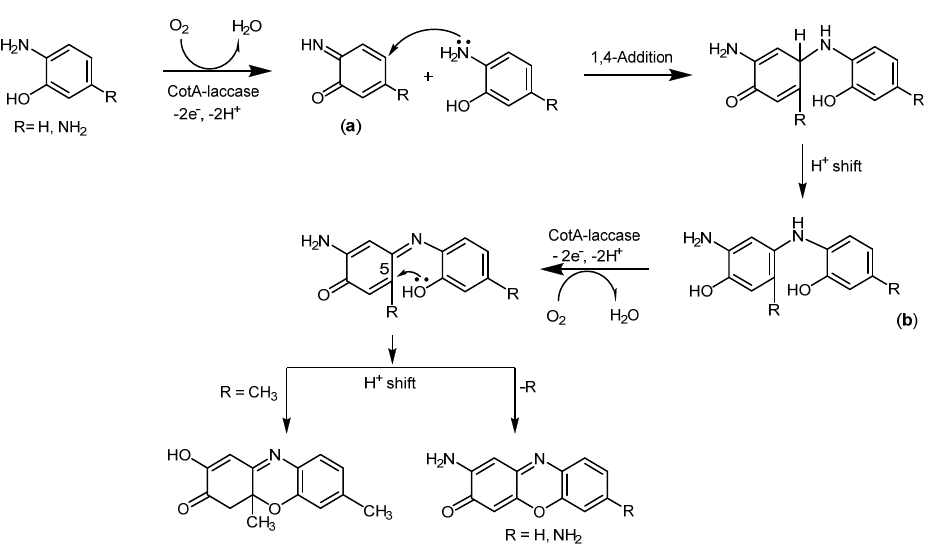
Scheme 15. Proposed pathways involved in the formation of phenoxazinones from